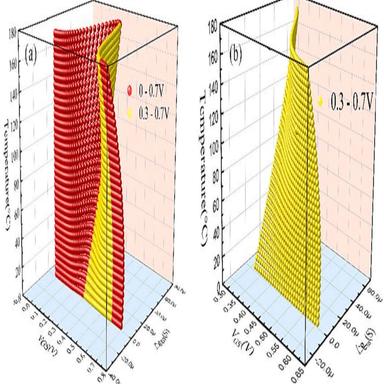
(a) The relationship diagram between gm, VGS (0–0.7 V) and T; (b) The relationship diagram between gm, VGS (0.3–0.7 V) and T.